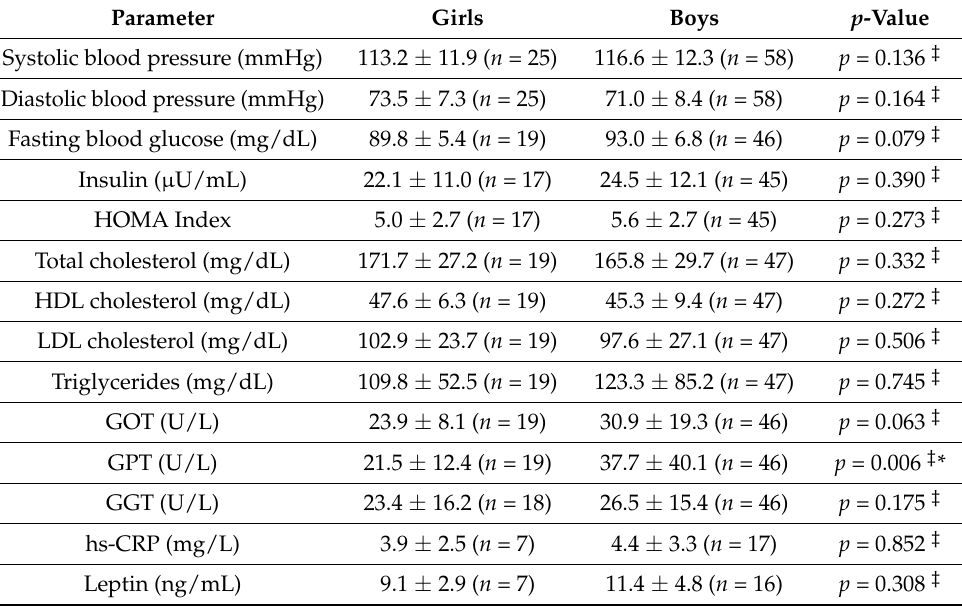
Table A3. Blood pressure and laboratory parameters of the group of sarcopenia present in girls and